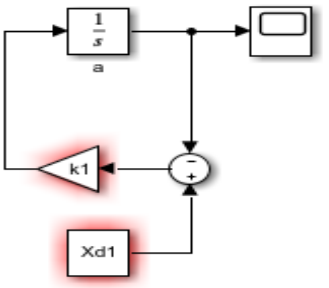
Figure 5. Diagram of blocks of 1, state variables.